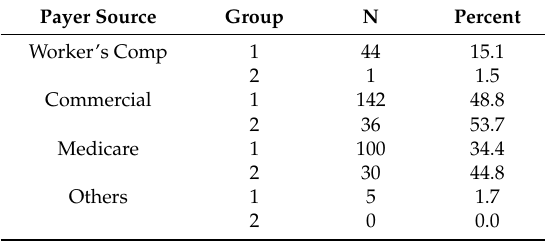
Table 2. Additional descriptive statistics (categorical) of each sample site. (Group 1 = Dallas; Group 2 =